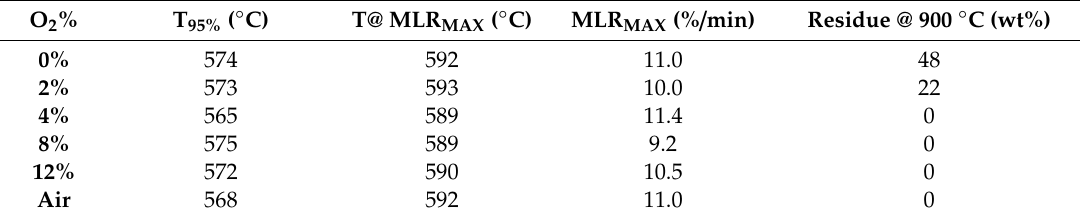
Figure 2. TGA and DTG plots of polyether ether ketone (PEEK) when heated at 10 ◦ C / min under pyrolytic conditions (black, square), 2% oxygen (red, circle), 4% oxygen (blue, upwards triangle), 8% oxygen (magenta, downwards triangle), 12% oxygen (green, diamond) and in synthetic air (brown, left-pointing triangle). Table 1. Summary of the data from the TGA of PEEK under di ff erent oxygen